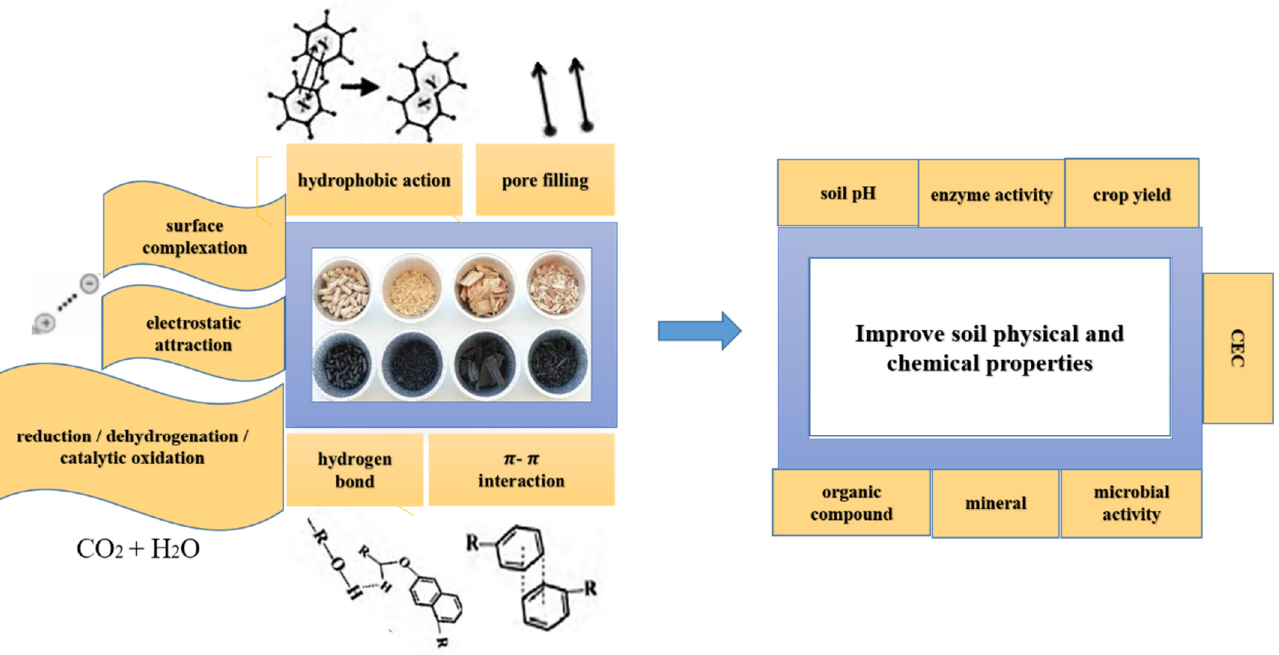
Figure 3. Mechanism of biochar remediation of soil pollution.